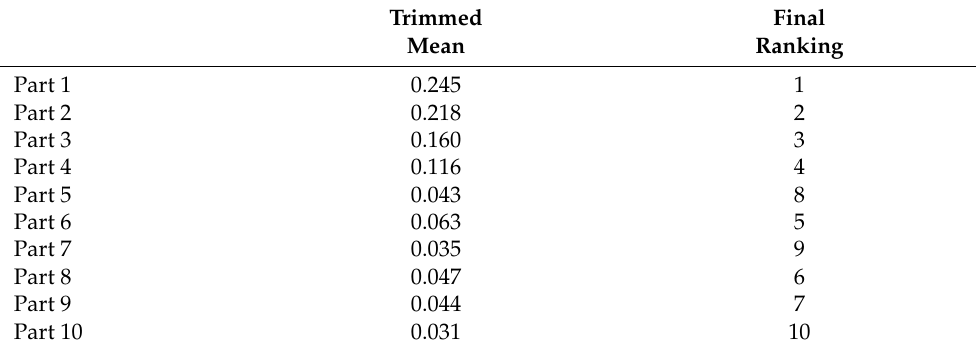
Table 6. Robustness analysis and final result of